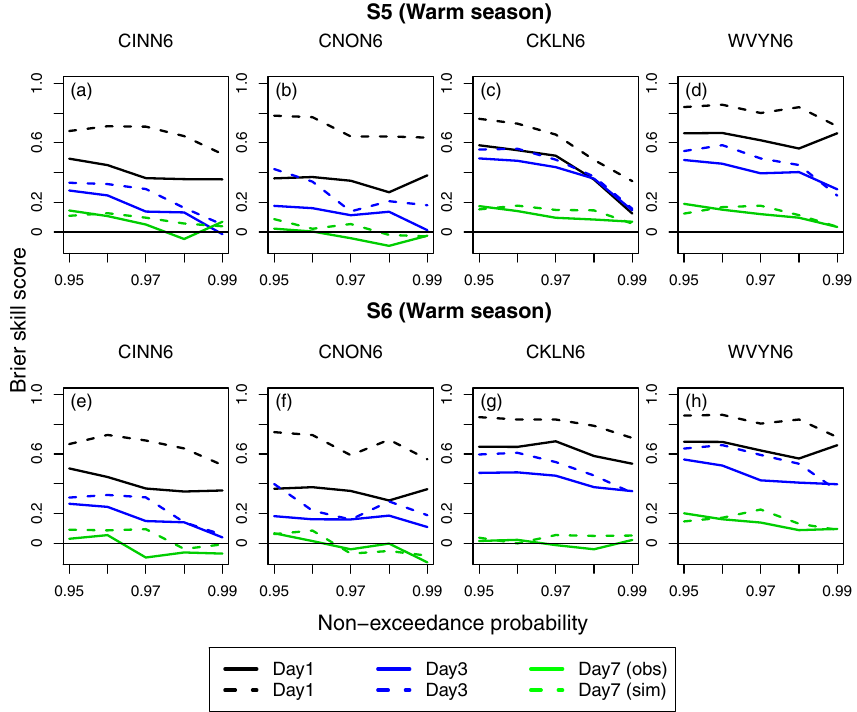
Figure 7. Brier skill score (BSS) of the mean ensemble flood forecasts for S5 (a–d) and S6 (e–h) vs. the flood threshold for forecast lead times of 1, 3, and 7 days during the warm (April–September) season for the selected basins. The BSS is shown relative to both observed (solid lines) and simulated floods (dashed